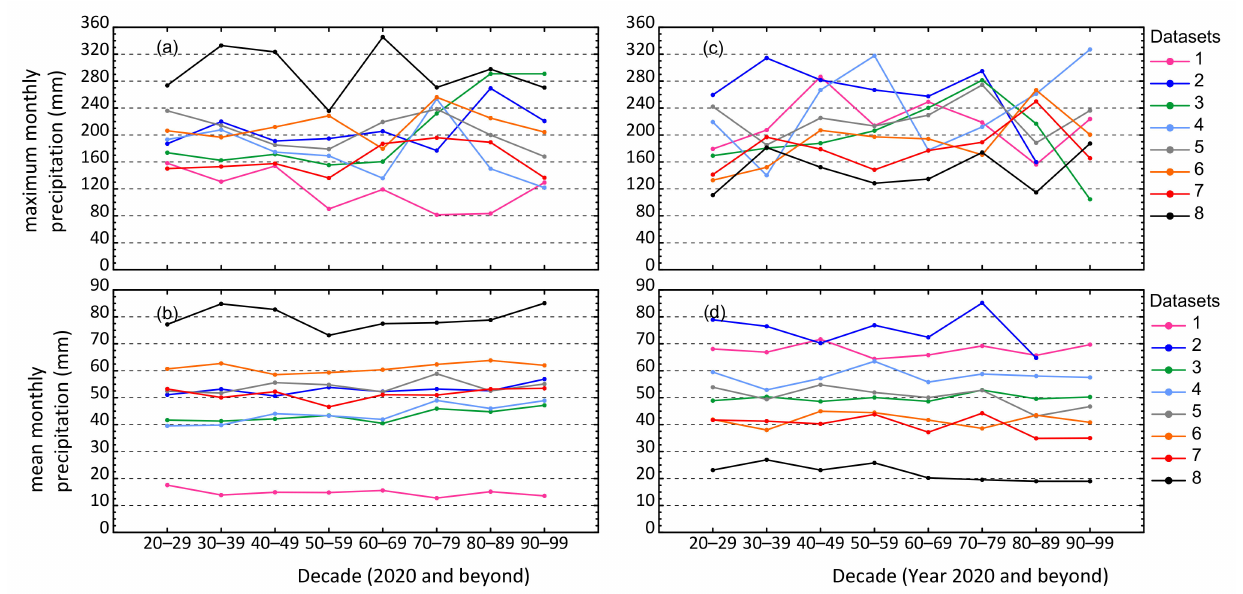
Figure 5. Mean and maximum monthly precipitation projections for the 2020–2099 period for the ( a , b ) RCP 4.5 and ( c , d ) the RCP 8.5